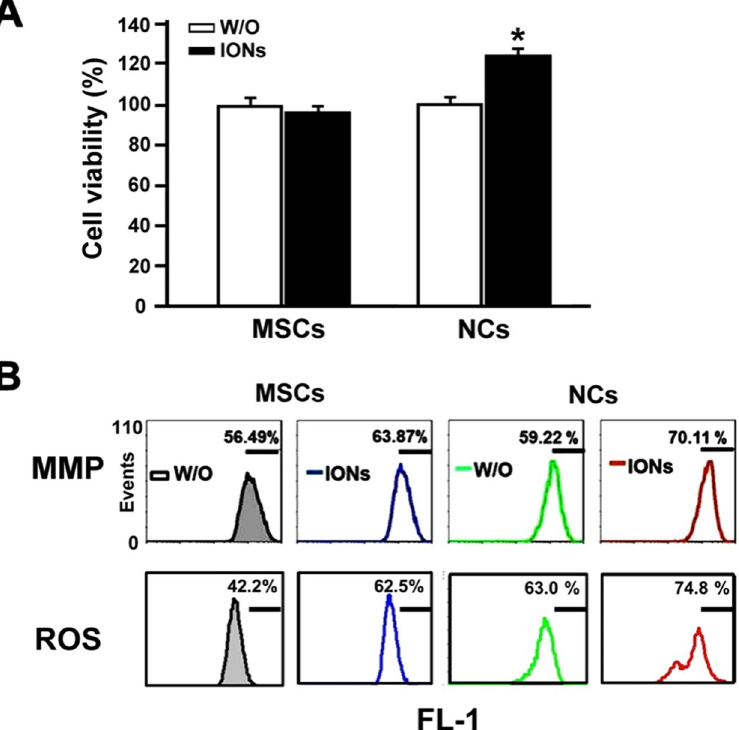
Figure 6. Measuring cell behaviour using three different assays. ( A ) Cell viability (MTT) assay, ( B ) mitochondrial membrane potential (MMP) and reactive oxygen species (ROS) assay (FL-1, fluorescent mean intensity). Human mesenchymal stem cells with or without 21 days of differentiation induction were treated with or without 100 μ g/mL ION for 24